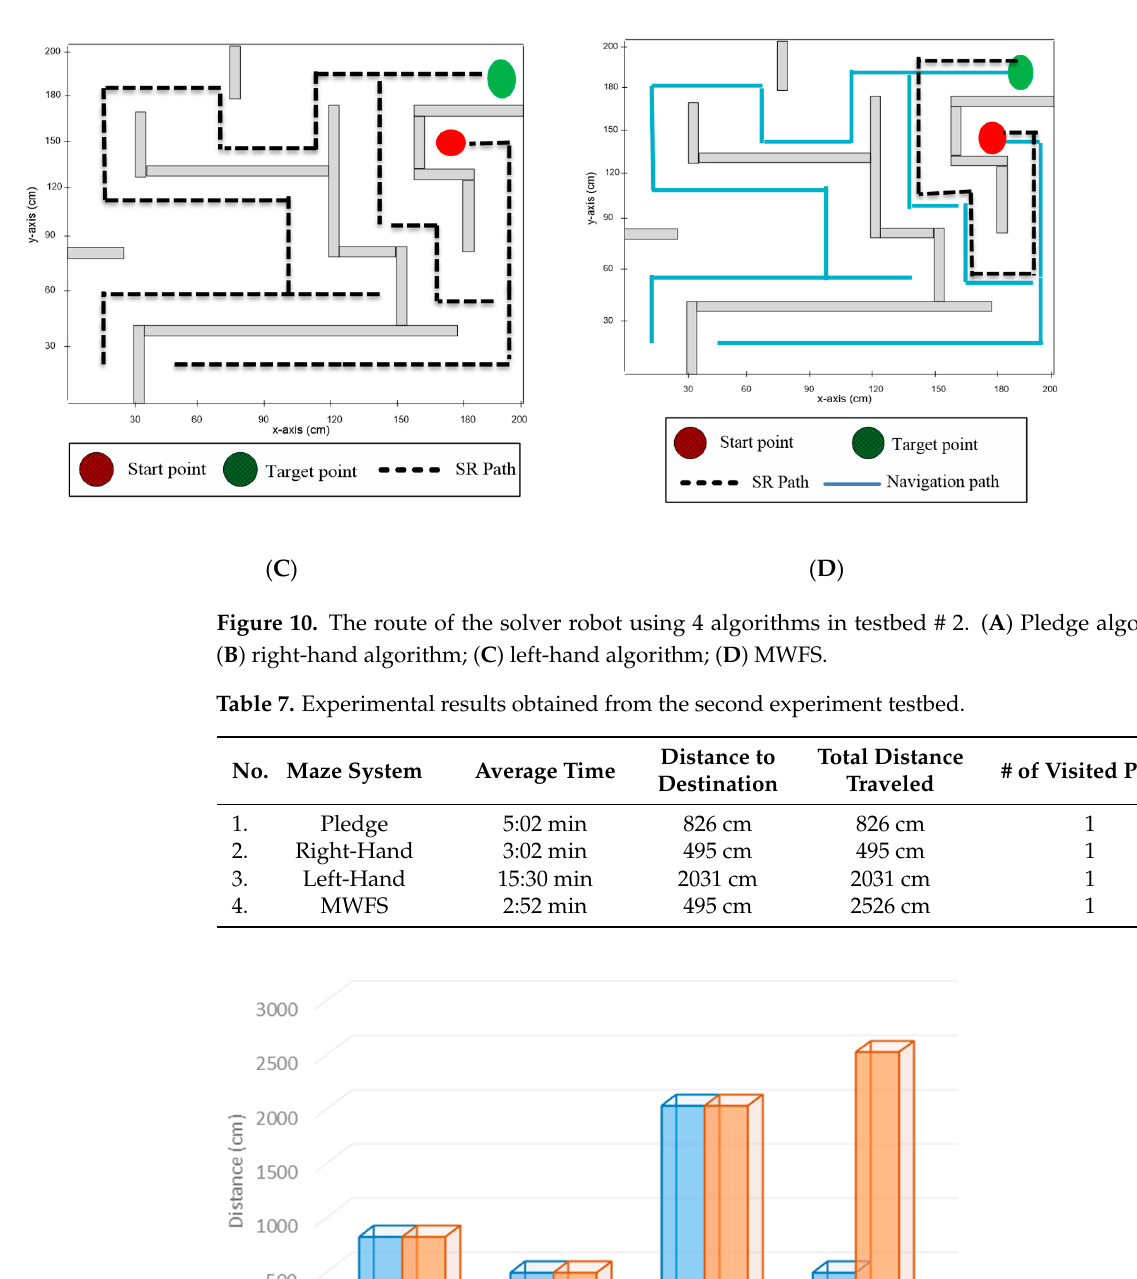
Table 8. Experimental results obtained from the third experiment testbed.